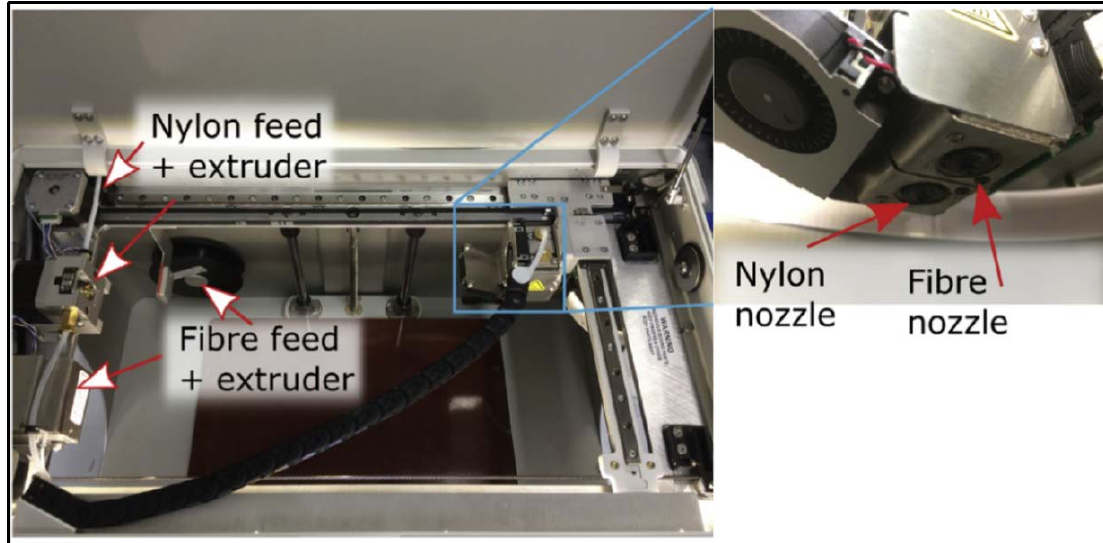
Figure 22. Dual nozzle system on MarkOne printer (available under a Creative Commons license [81]).